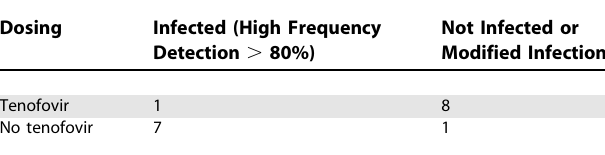
Table 3. Contingency Table for Dosing and Outcome of Virus Challenge: Analysis for Modified Outcome (i.e., ‘‘ Complete ’’ Protection or Reduced Frequency of Virus Detection) Associated with Tenofovir Gel Administered Intrarectally Prior to Virus Challenge; p ¼ 0.003